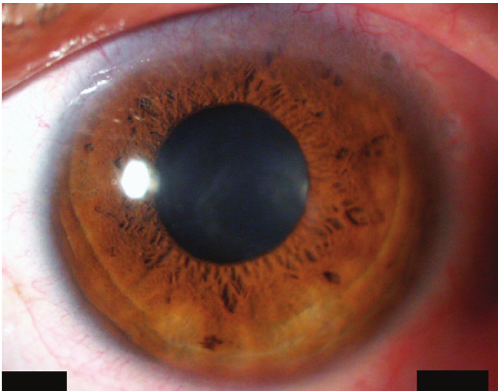
Figure 1: Slitlamp microscopic image of a 25-year-old man showing corneal shield ulcer at 40 days after beginning of treatment. After diminishing atopic conjunctivitis and corneal shield ulcer, calcific corneal opacities developed under the corneal epithelium.